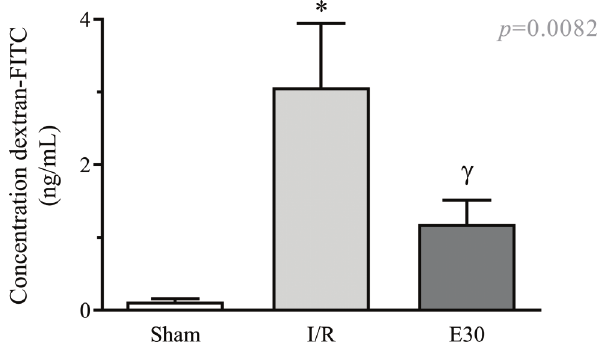
Figure 2 - The effect of reperfusion in intestinal I/R on intestinal mucosal permeability. In rats with I/R injury, the superior mesenteric artery was clamped (45 min), followed by intestinal reperfusion (2h). Estradiol (180 m g/kg, i.v.) was administered 30 min after the induction of intestinal ischemia (E30). Sham- operated rats were used as controls. Data are expressed as the mean ± standard error of the mean (SEM) from 6 animals. * p o 0.0001 compared with sham; g p =0.0036 versus intestinal I/R. I/R, ischemia and reperfusion.